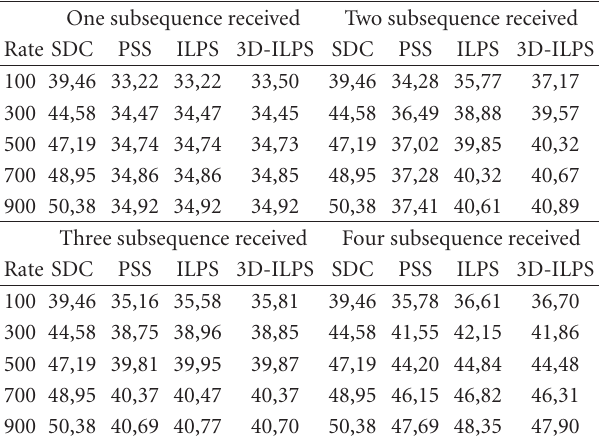
Table 3: Performance of depth view, Breakdance, without packet